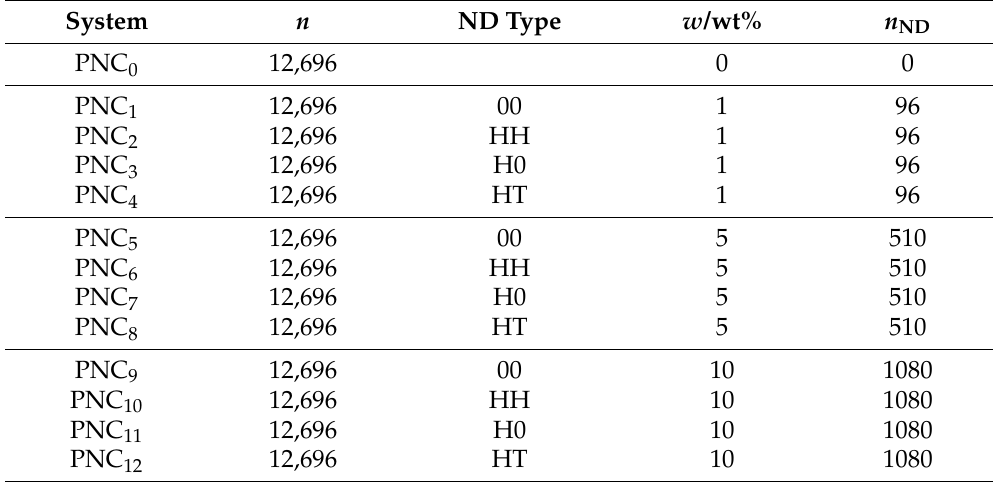
Table 2. Summary of systems studied. Information includes the system id number, the number of di-BCP chains ( n ), ND type, the mass fraction of NDs ( w /wt%) and the total number of NDs ( n ND ).